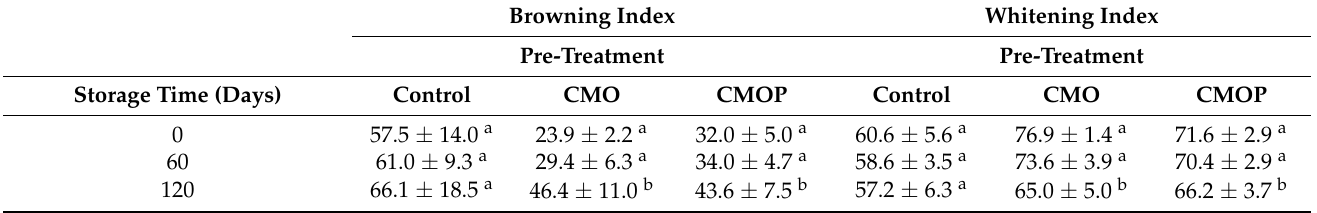
Table 5. Impact of storage time on the browning and whitening index of the dried apple slices 1